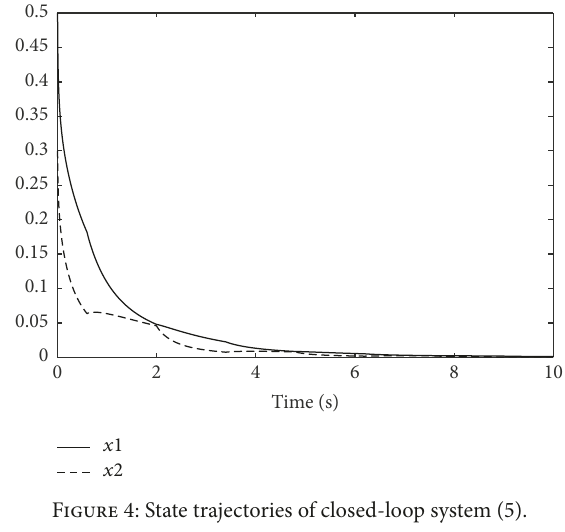
Figure 4: State trajectories of closed-loop system (5).